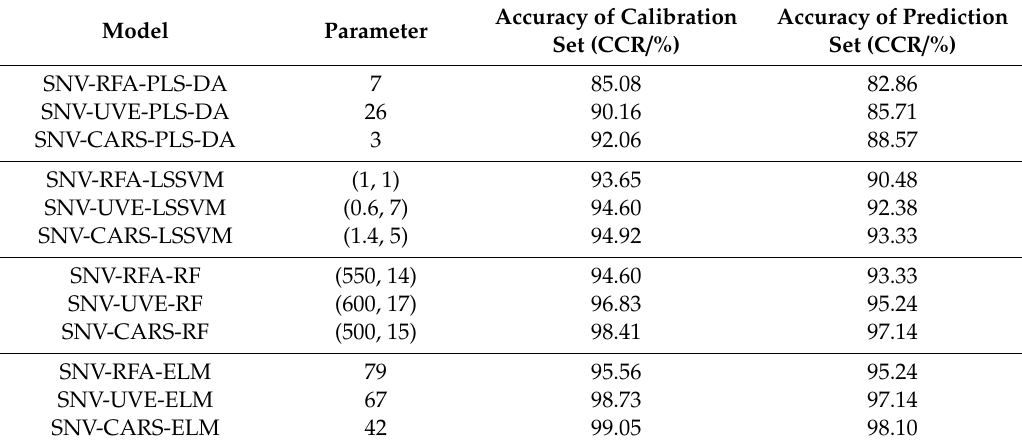
Table 4. Modeling analysis based on characteristic